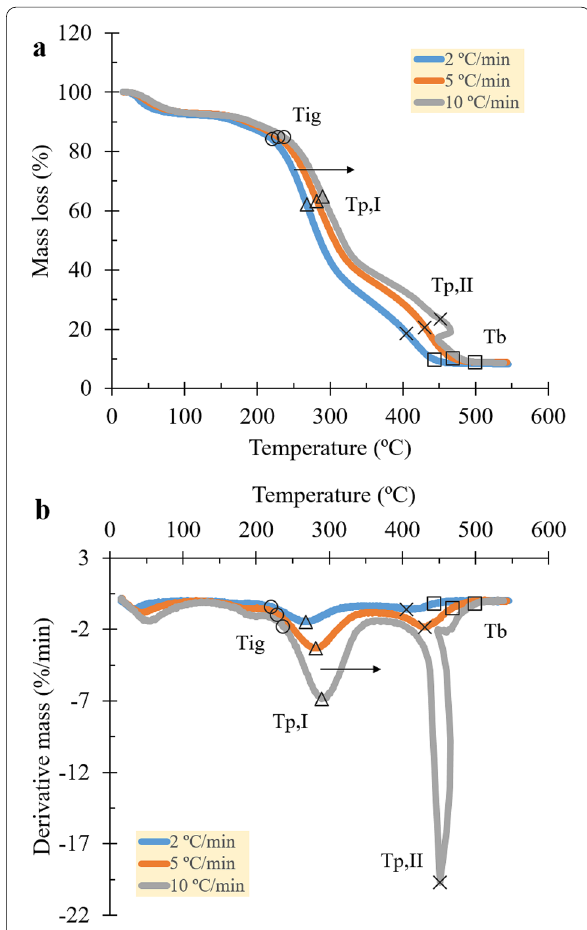
Fig. 3 a TG and b DTG signals with plots of the characteristic temperatures for all heating rates (1st iteration sample)